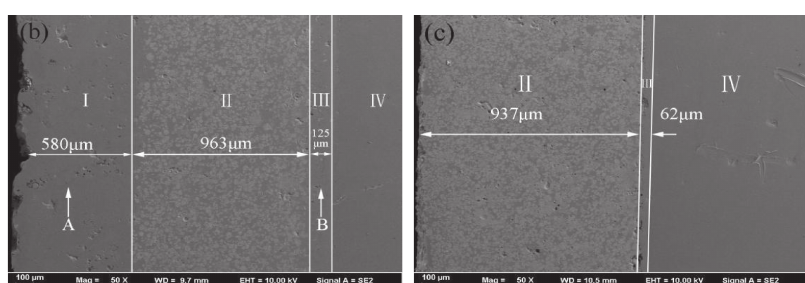
Figure 3: microscopic morphology and microstructure of coating cross section: